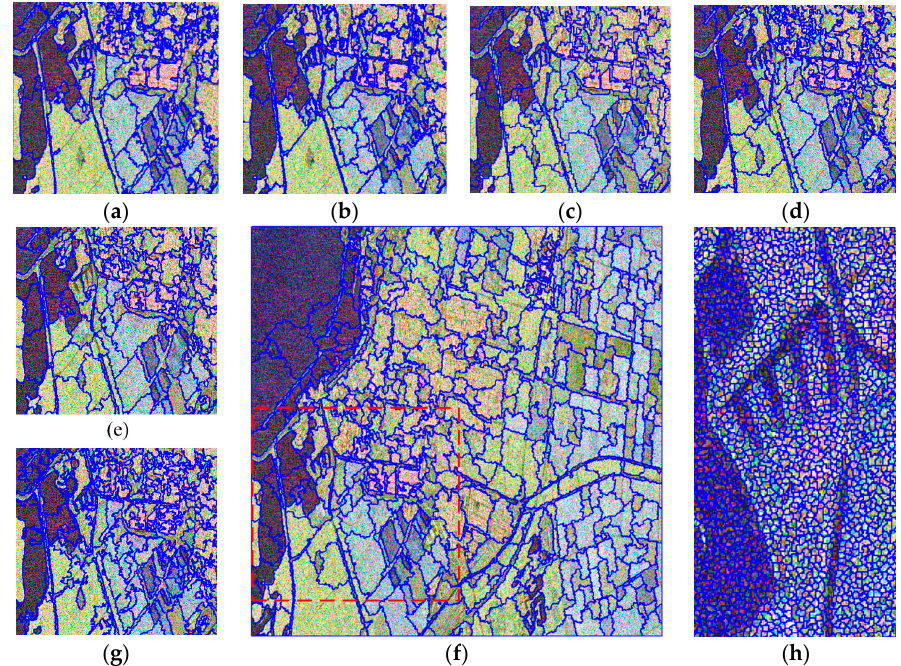
Figure 7. Segmentation results of the single-look RADARSAT-2 PolSAR image using different methods: ( a ) FFD, ( b ) FPD, ( c ) IFGB, ( d ) IFWS, ( e ) IFKS, ( f ) IFGS, ( g ) IFGS-S, and ( h ) SLIC (local enlarged drawing of central left part of the superpixel map). ( a – e ) and ( g ) show screenshots of the results in the red dashed rectangle of ( f ). Table 2. Segmentation accuracy measures of the single-look RADARSAT-2